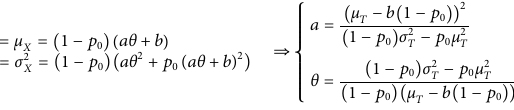
Method 2: Skewness-kurtosis-ratio matching